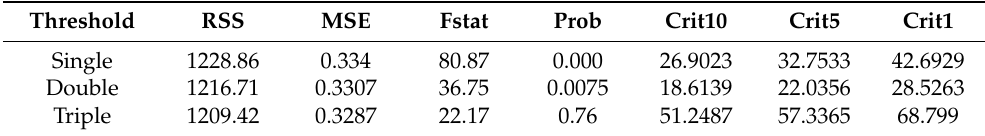
Table 7. Panel threshold effect test (BS = 400).